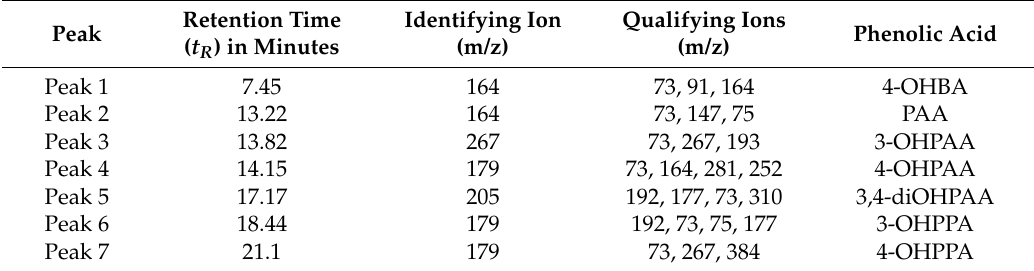
Table 1. Phenolic acids identified in fermentations containing rutin